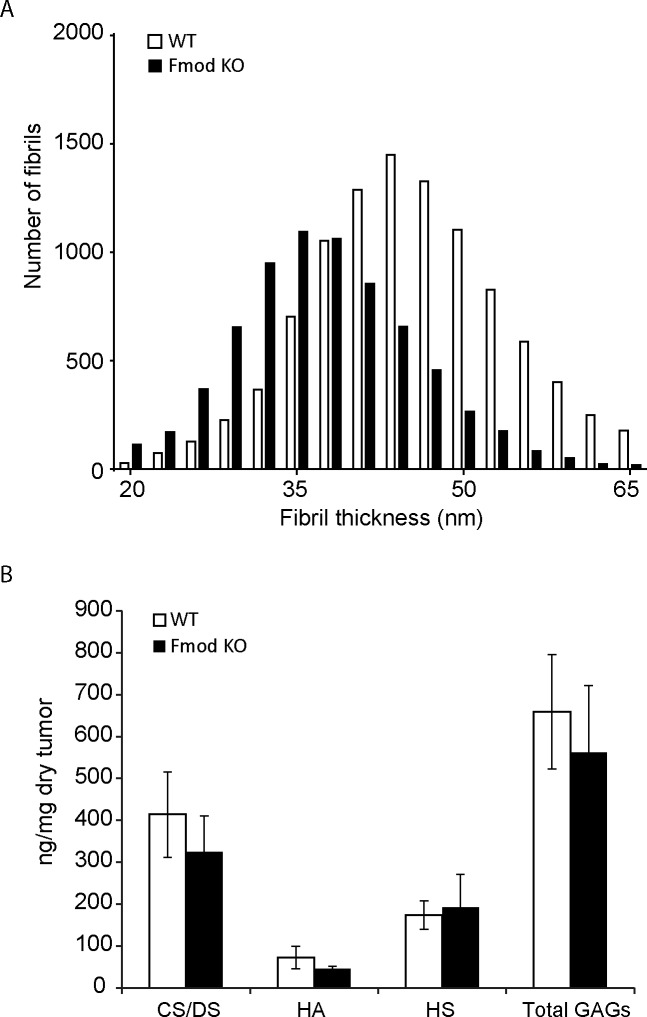
Ultrastructural and content comparison of collagen and GAG composition A. Histogram of collagen fibril diameter in OOC38 tumors measured in electron microscopic images (WT n = 10291, Fmod-/- n = 7119; Kolmogorov-Smirnov test p < 0.0001). Average collagen fibril diameter was: WT 44.8 nm (n = 4), Fmod-/- 37.8 nm (n = 5), Student’s t test p = 0.004. B. Total Chondroitin/Dermatan sulfate (CS/DS), Hyaluronic acid (HA), Heparan Sulfate (HS) and total glycosaminoglycan content (Total GAGs) represented in ng/mg of tumor by dry weight (WT n = 4, Fmod KO n = 4).